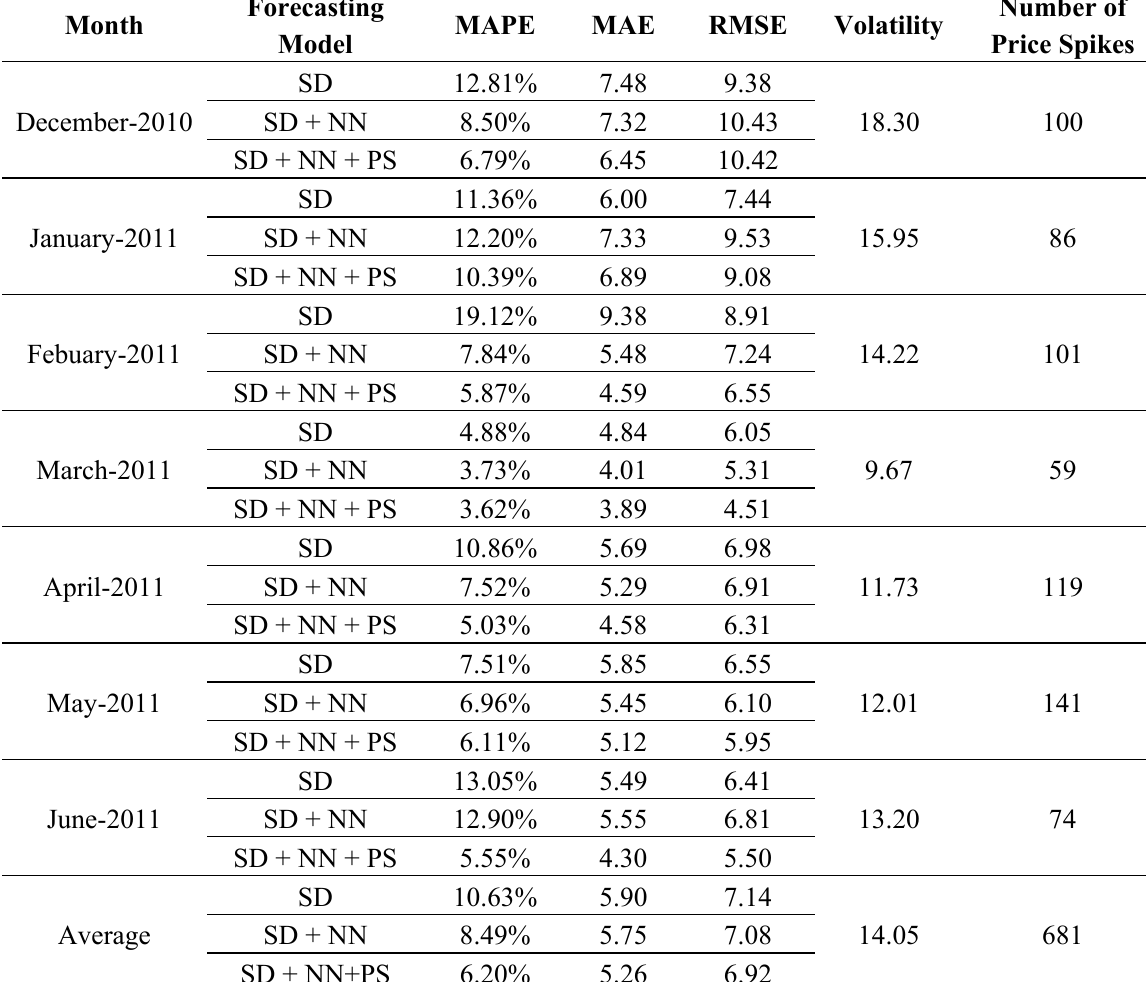
Table 1. Performances of the proposed hybrid model for hourly electricity price